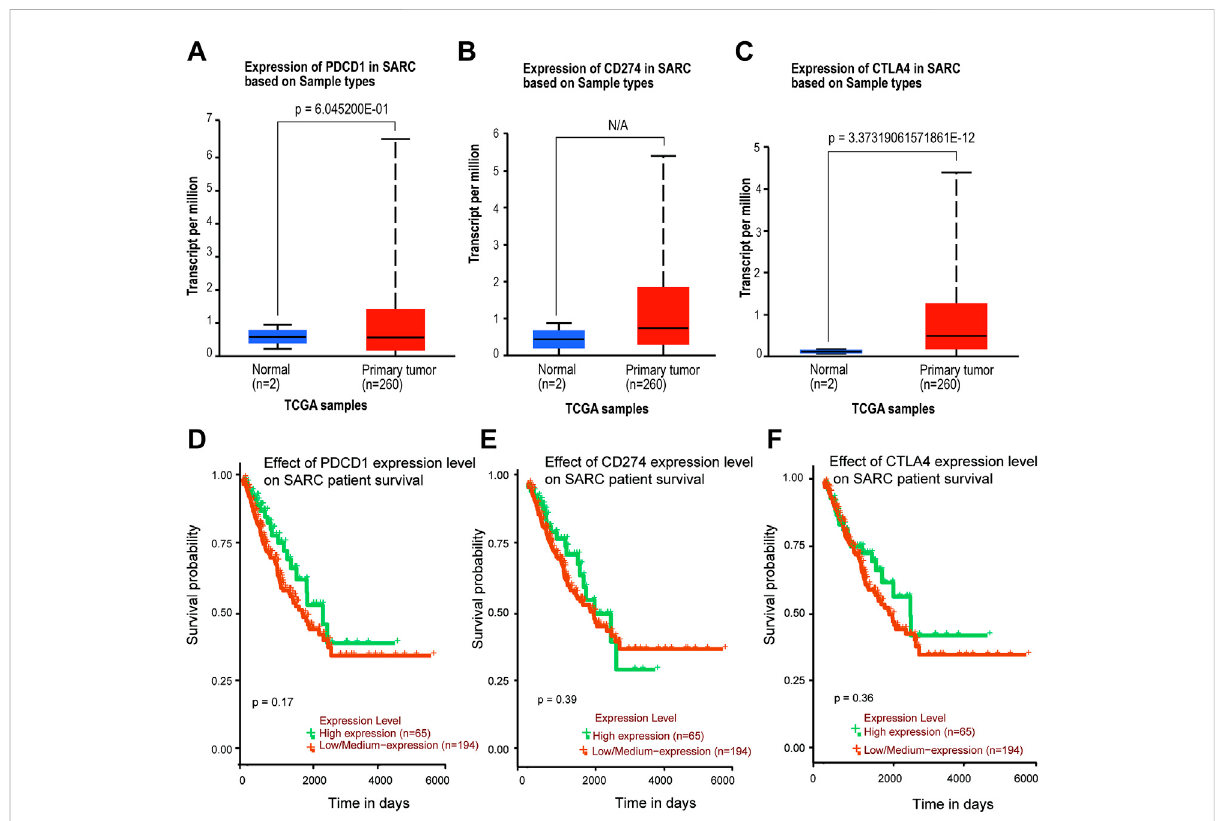
FIGURE 5 Expression level and survival probability of PD-1, PD-L1, CTLA-4 genes in SARC. (A,B,C) PD-1, PD-L1, CTLA-4 genes expression in SARC patients. Box plots showing distribution of tumor (Red) and paired non-tumor (Green) PD-1 (A), PD-L1 (B) , CTLA-4 (C) genes expression in SARC. (D,E,F) Kaplan – Meier survival curves comparing high and low/medium expression of PD-1 (D) , PD-L1 (E) , CTLA-4 (F) in SARC. Plots were generated using UALCAN tools (http://ualcan.path.uab.edu/) and curated